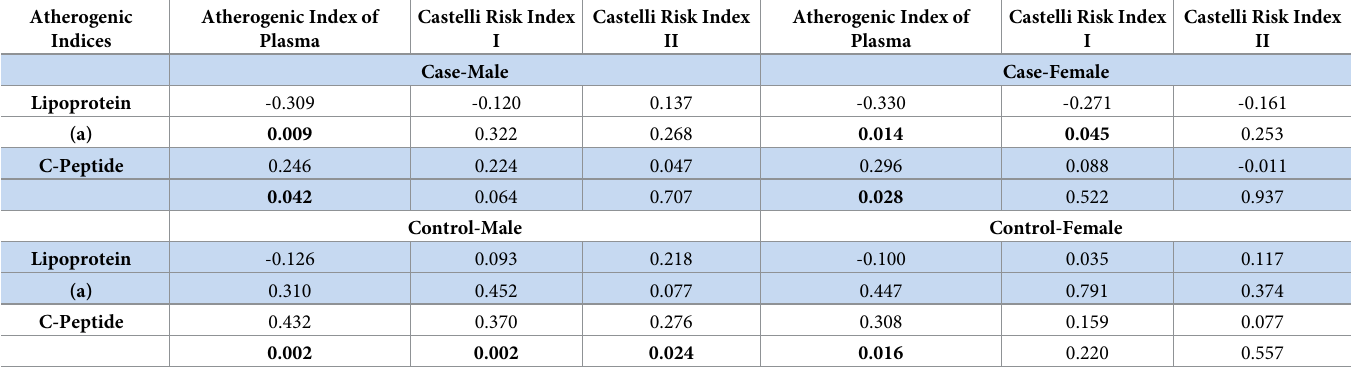
Table 5. Pearson correlation coefficients for the relationship between lipoprotein (a) and C-Peptide with atherogenic indices of plasma according to gender.